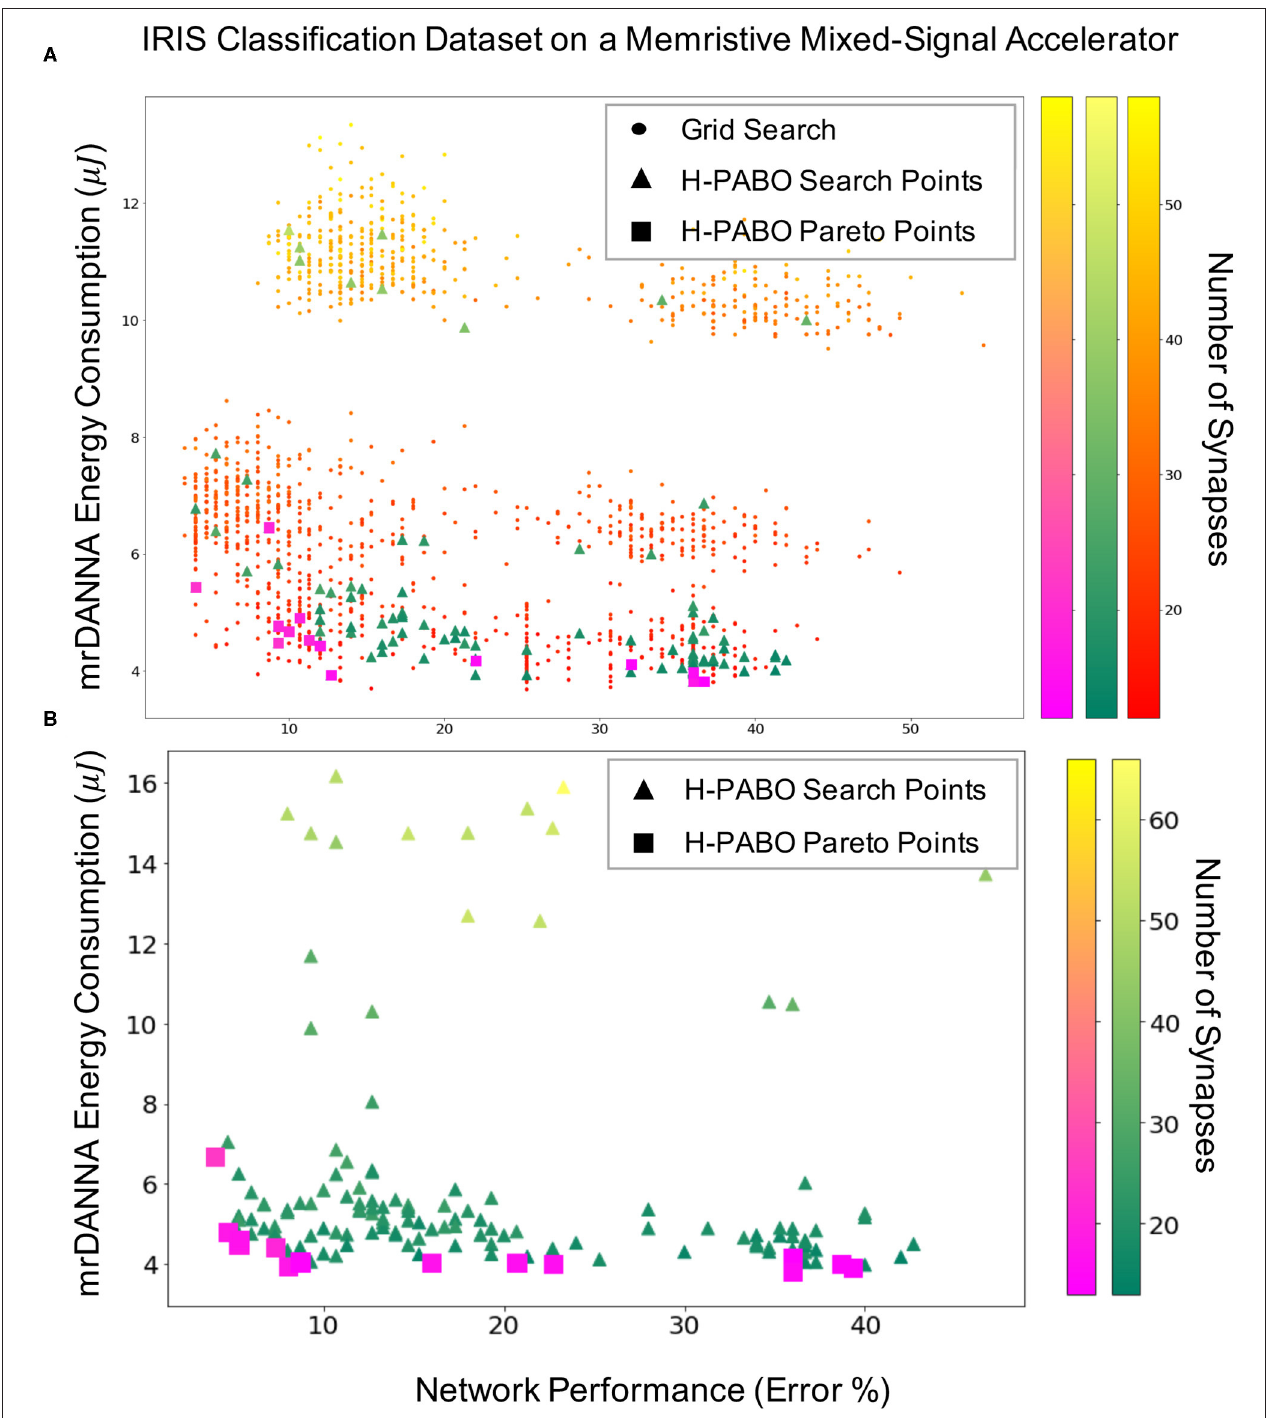
FIGURE 6 | H-PABO results for three-objective hyperparameter optimization (network performance, hardware energy consumption, and number of synapses) for Iris classification dataset on mrDANNA with HP search space of (A) , 1458, case study six, (B) 35,640, case study eight in Table 4 .